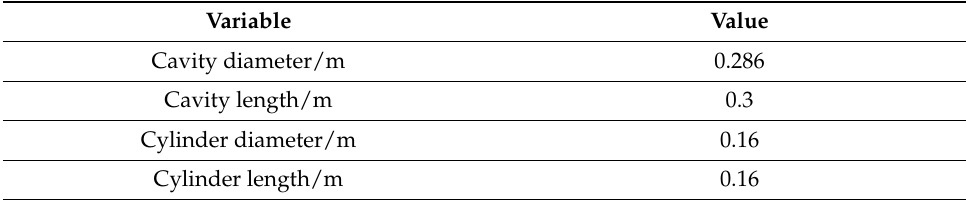
Figure 5. Results of RCS calculation and experiment. ( a ) Horizontal polarization ( b ) Vertical polar- ization.